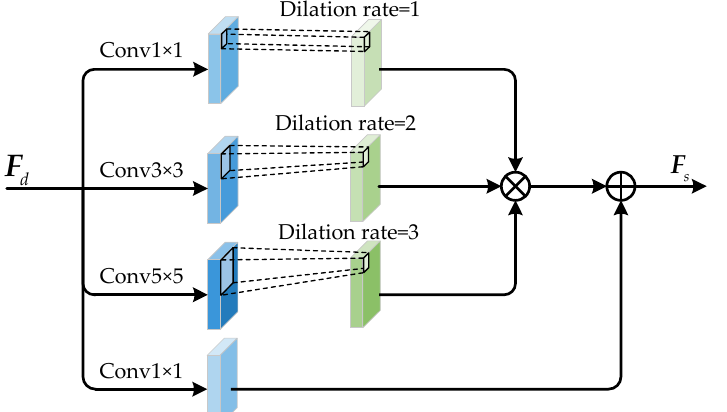
Figure 5. Illustration of the pyramid aggregation module.